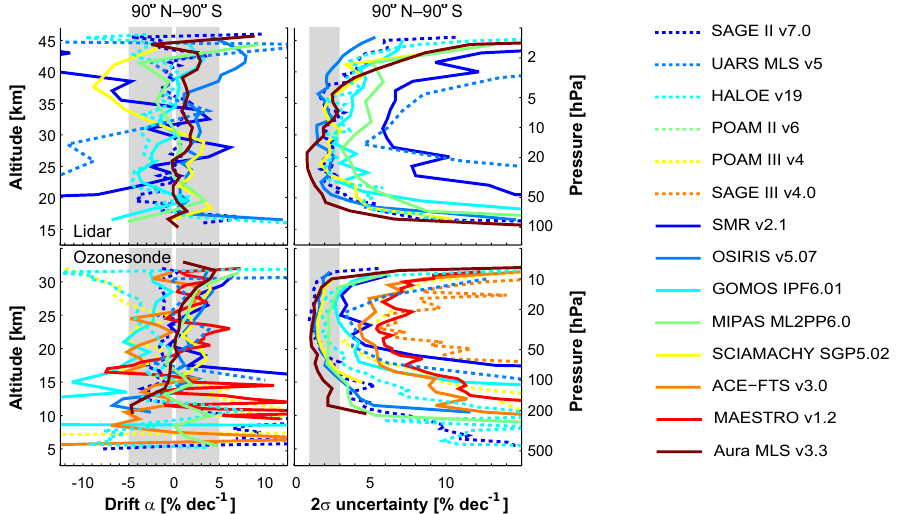
Figure 12. Overview of the drift ¯ α (left column) and its 2 σ uncertainty (right) of all satellite ozone records relative to the lidar (top row) and ozonesonde (bottom) networks. Dashed lines indicate instruments that ceased operations prior to 2006. The analysis is done in the native system of each satellite record. The decadal stability of most records remains within ± 5%decade − 1 in the middle and upper stratosphere (shaded area). POAM II and SAGE III drift results are not displayed in the lower left panel to avoid